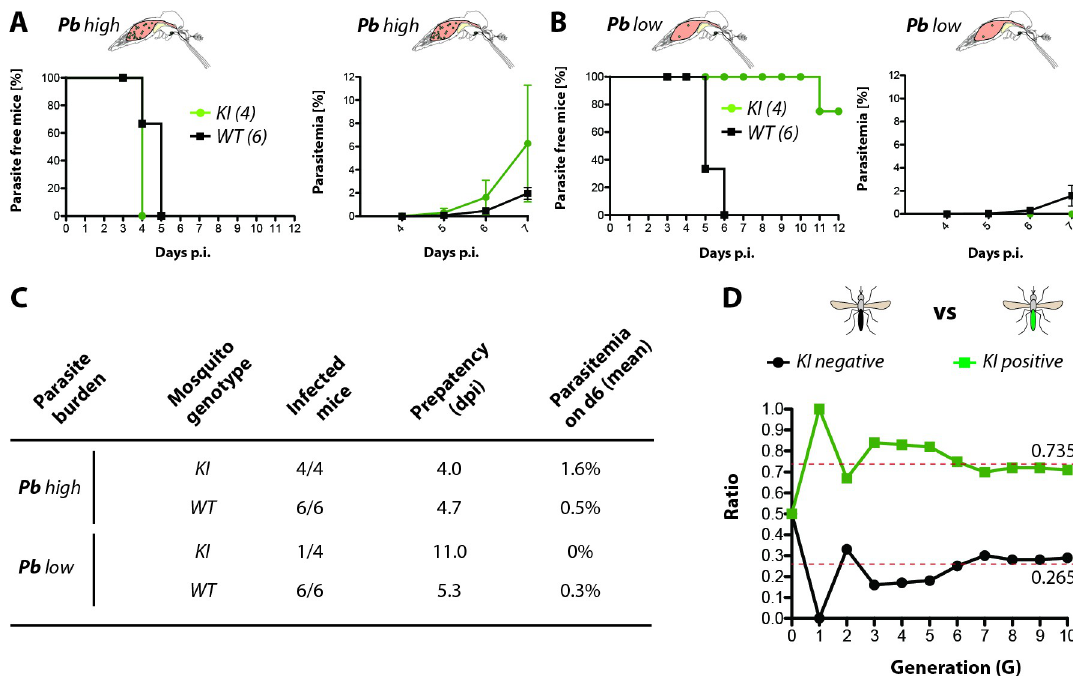
Fig 6. Saglin promotes successful transmission at low infection densities. A) Percentage of parasite free mice after being exposed to the bites of ten sag(-)KI or wild-type mosquitoes with high ( Pb high) or B) low ( Pb low) parasitemia. The number of mice is given in brackets. The growth of asexual blood stages in infected mice was monitored between day 4 and day 7 after mosquito exposure. C) Table summarizing results illustrated in A and B. Mosquito genotypes, numbers of infected / exposed mice as well as mean prepatency in days and mean parasitemia at day 6 post infection are indicated. Prepatency is defined as the time between the mosquito bite and the first observation of parasite blood stages. D) Evolution of the presence of the sag(-)KI transgene in a colony established by crossing homozygous sag(-)KI females to wild-type males (G0) over 10 generations. The proportion of transgenic (homozygote + heterozygous females and hemizygous males) and wild-type larvae was tracked by flow cytometry (COPAS) at each generation, using the 3xP3-GFP fluorescence marker disrupting the saglin coding sequence. Dotted red lines indicate the expected ratios for an X-linked allele in Hardy-Weinberg equilibrium.